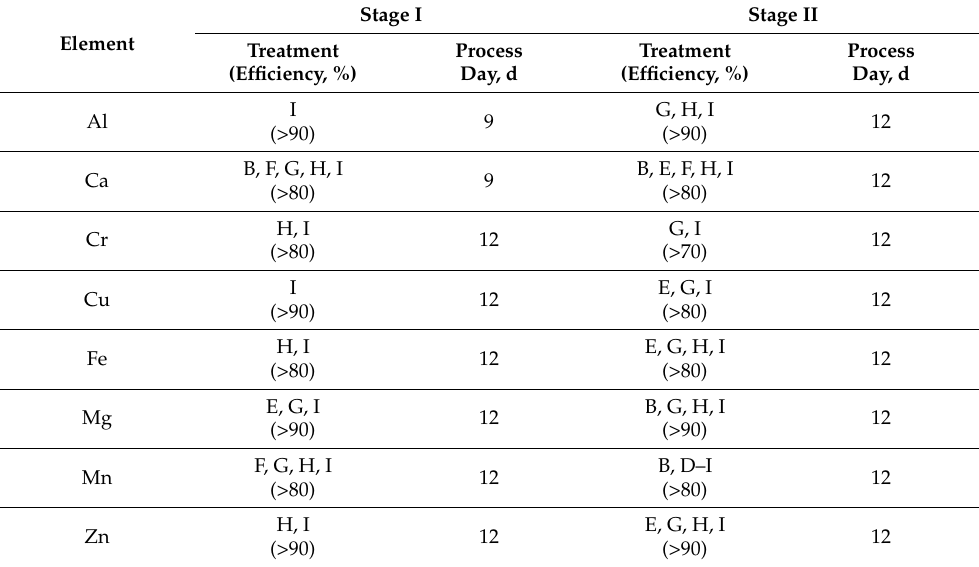
Table 5. Combinations with the highest leaching efficiencies and the most favorable process time.